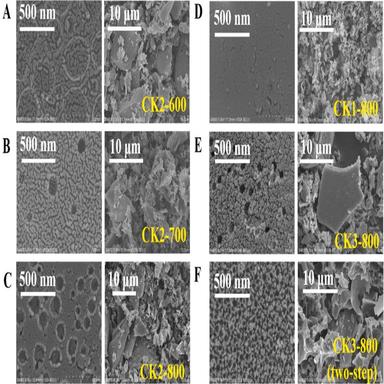
SEM images of carbon materials.